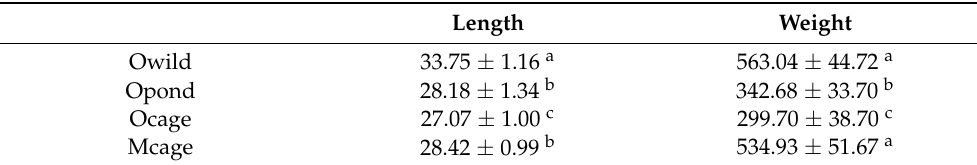
Table 4. Total length and weight of Sparus aurata individuals (N = 120, 30 per origin) collected at the following four sampling origins: Olhão – wild (Owild), Olhão – aquaculture in earth ponds (Opond), Olhão – sea-cage aquaculture (Ocage), Madeira – sea-cage aquaculture (Mcage). Different letters (a, b,